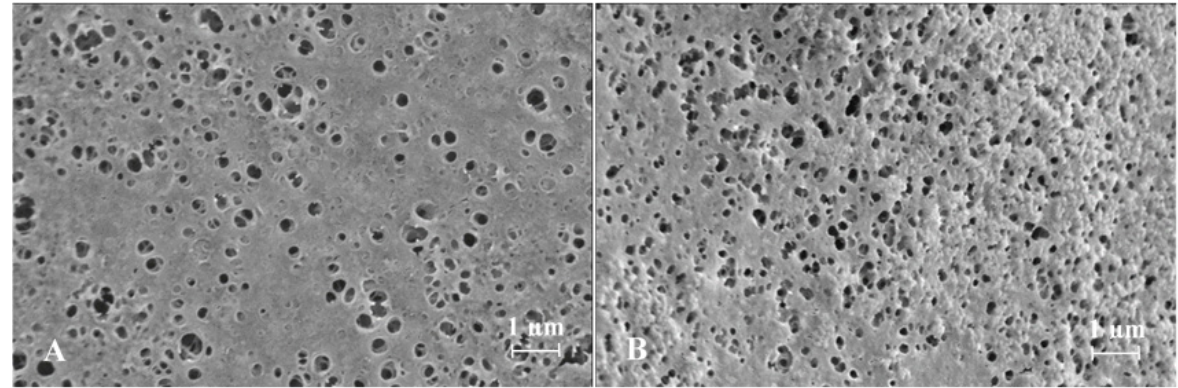
Figure 2. Scanning electron microscopy image of the pores on the surface of spherical in situ forming gels prepared for formulations containing 200 mg eq./g bedaquiline fumarate salt in PLGA5050A/NMP 20/80% ( w / w ) (Panel ( A ), formulation 1) and in PLGA7525A/NMP 20/80% ( w / w ) (Panel ( B ), formulation 2).